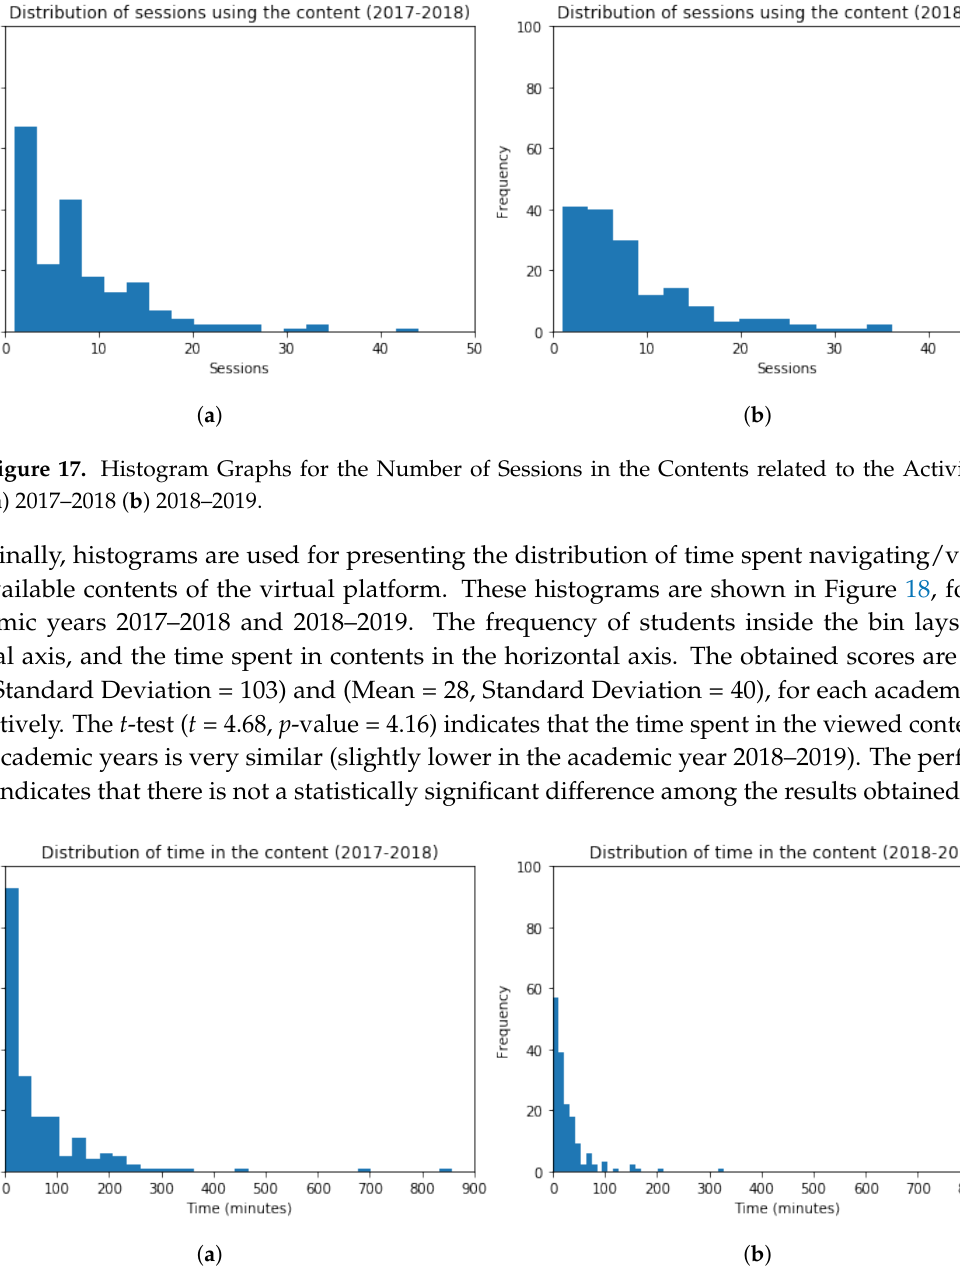
Figure 18. Histogram Graphs for the Time spent in the Contents related to the Activity. ( a ) 2017–2018 ( b )